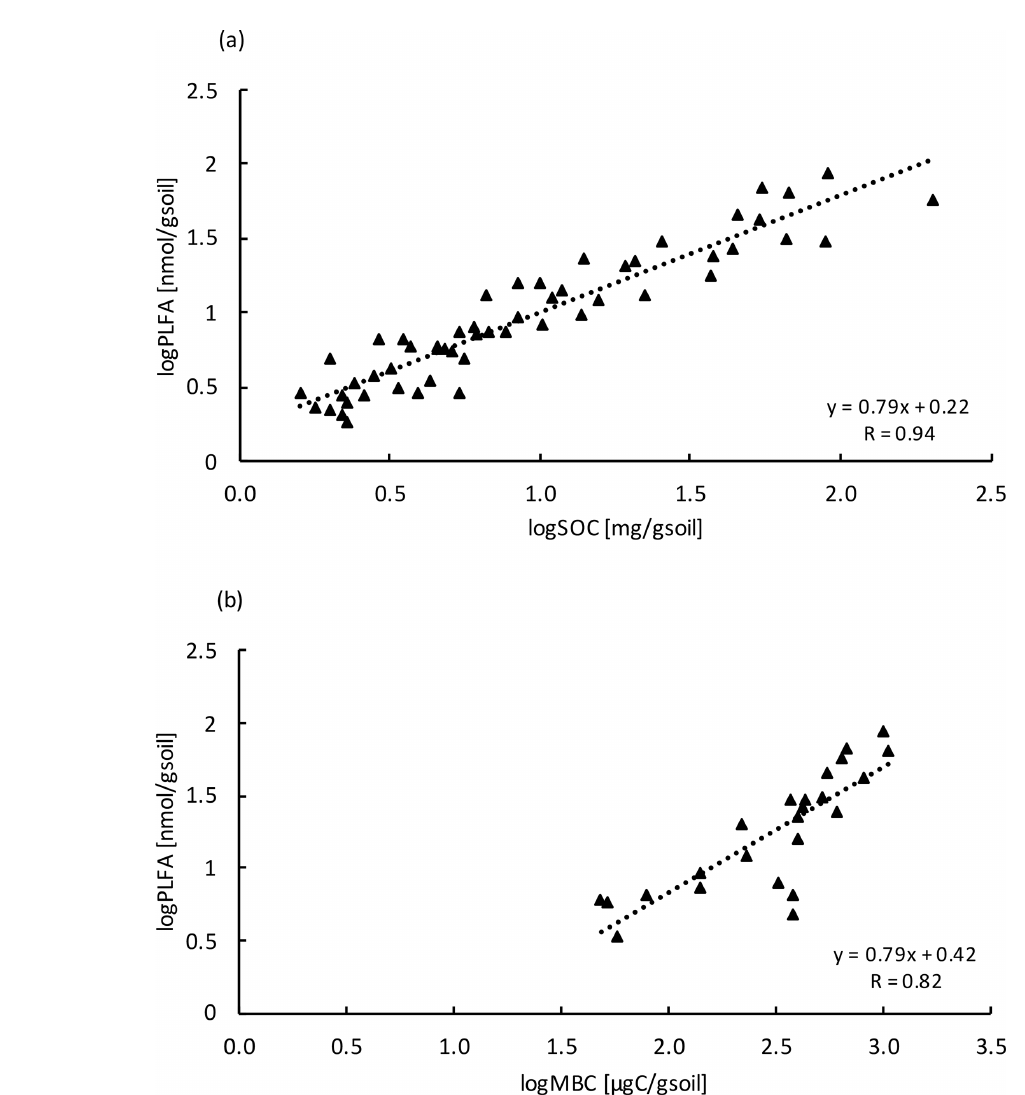
Figure A3. Relationship between (a) PLFA with SOC ( n = 54) and (b) PLFA with MBC ( n = 24) at all depth increments. Values were log transformed to meet